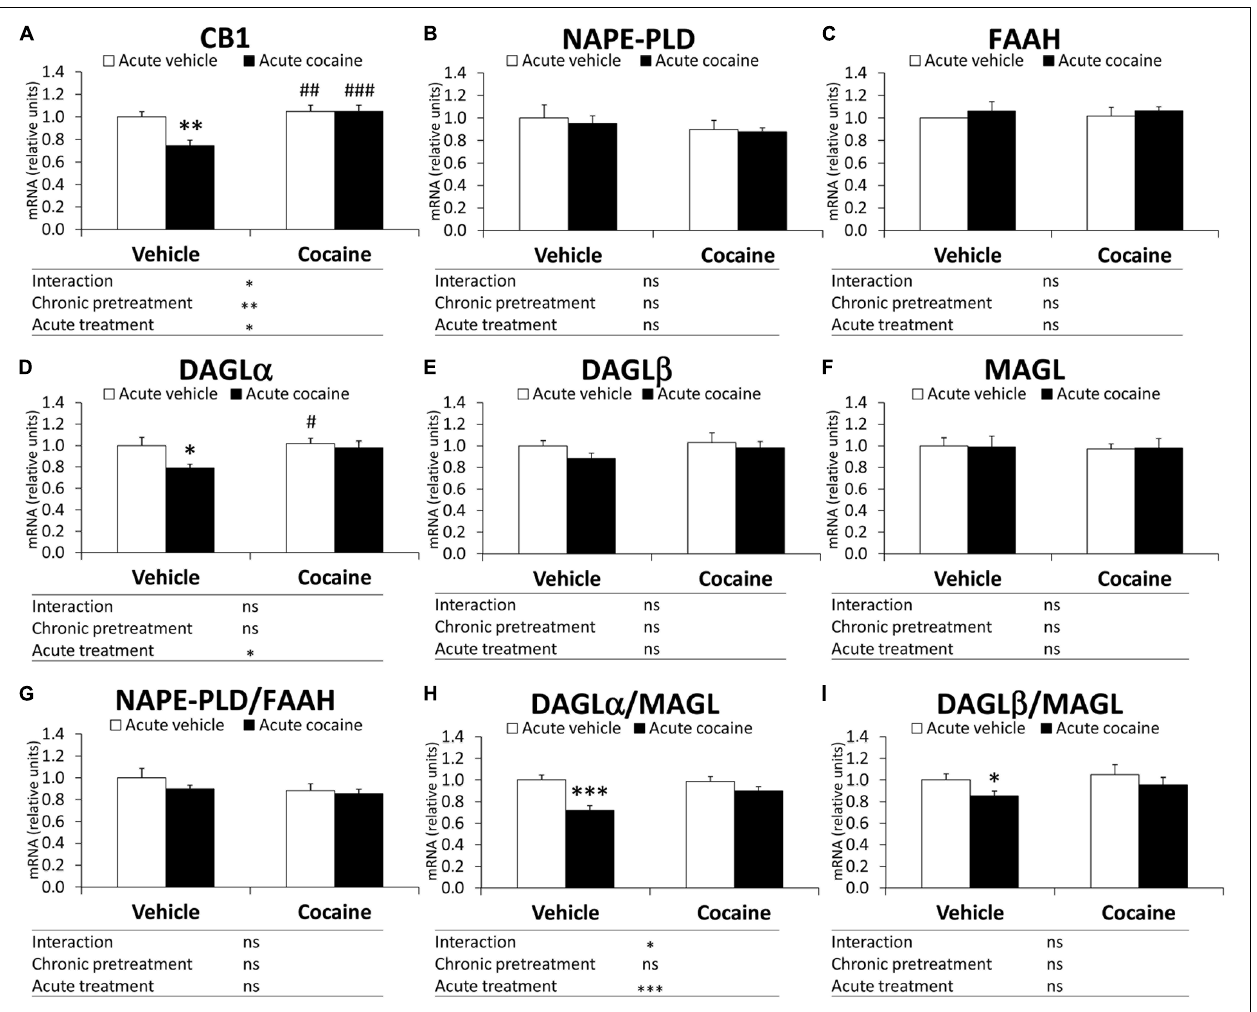
and cocaine). Histograms represent the mean ± SEM ( n = 8/group). Two-way ANOVA: ns, no significance; ∗ P < 0.05, ∗∗ P < 0.01, ∗∗∗ P < 0.001. Bonferroni: ∗ P < 0.05, ∗∗ P < 0.01, ∗∗∗ P < 0.001 vs. vehicle–vehicle group; # P < 0.05, ## P < 0.01, ### P < 0.001 vs. vehicle–cocaine